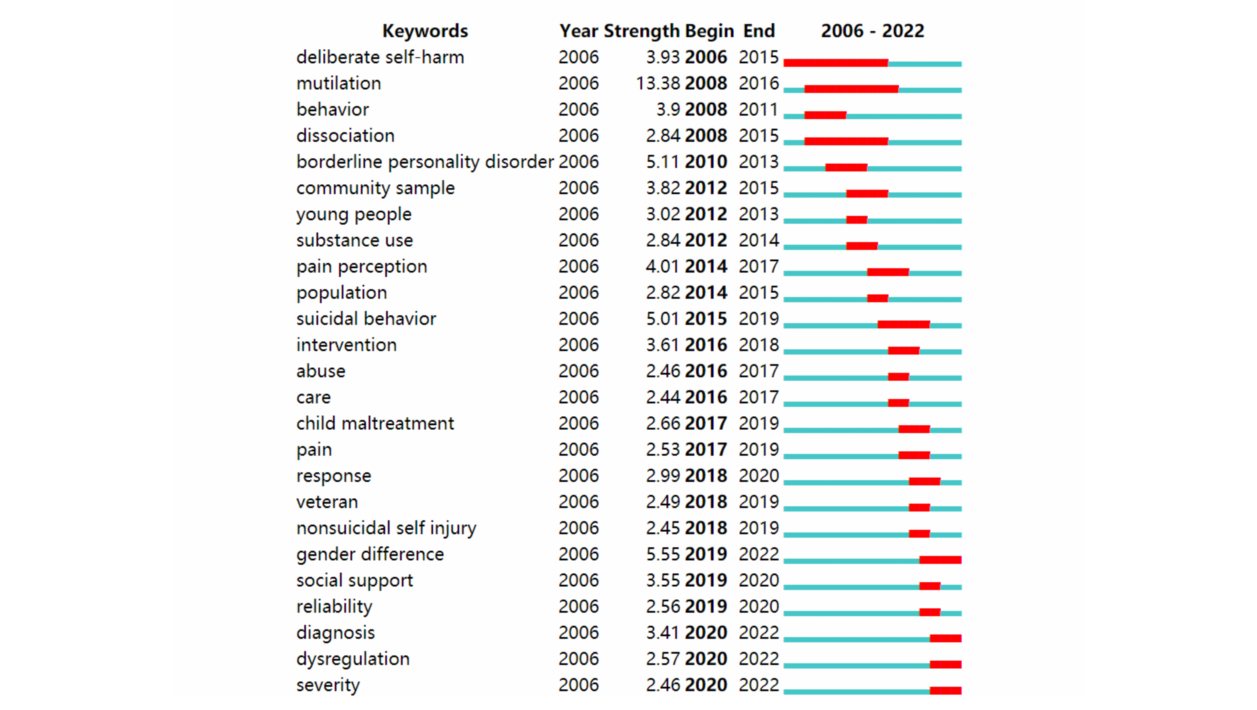
FIGURE14 Top 25 keywords with the strongest citation bursts generated by CiteSpace. The blue line is the time interval, the red line is the time period with a keyword